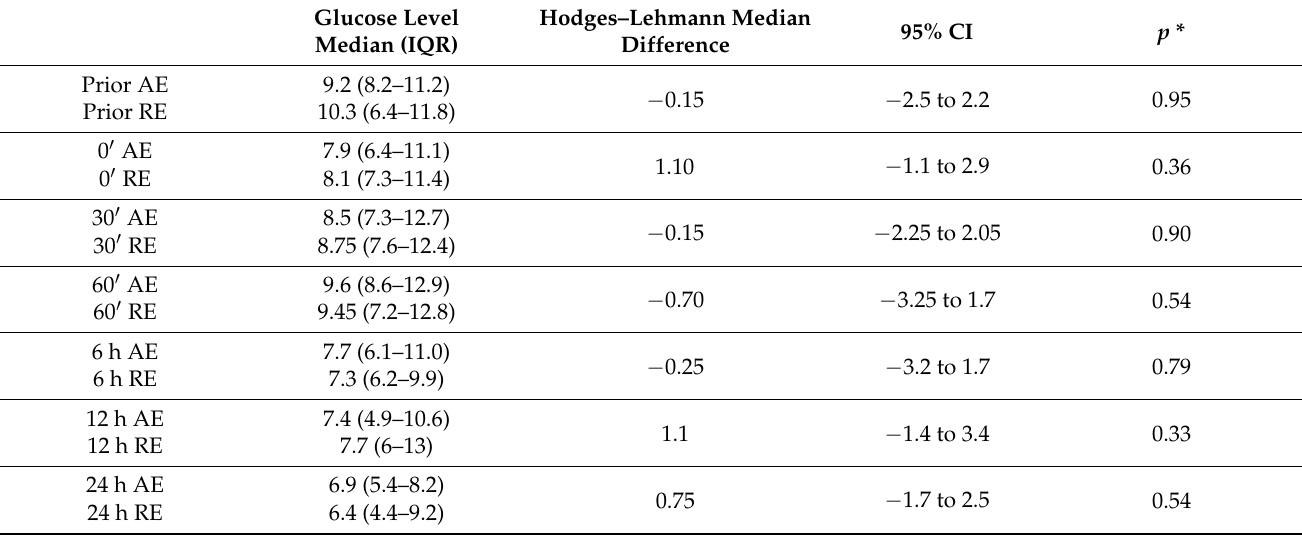
Table 3. Differences in glucose levels at different time points comparing aerobic and resistance exercise, measured by IsCGM.